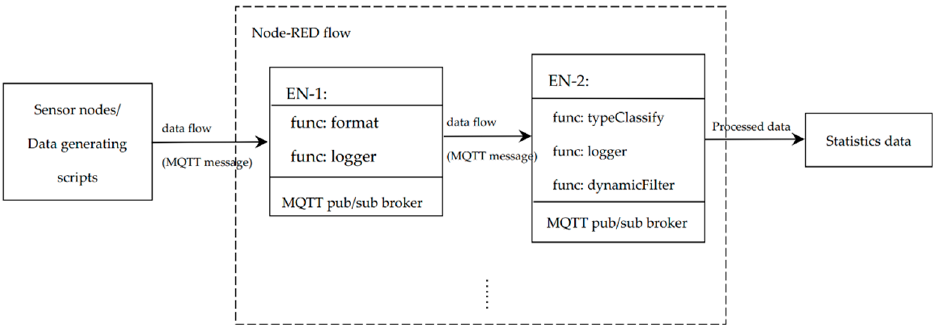
Figure 3. Architecture of the simulation environment.